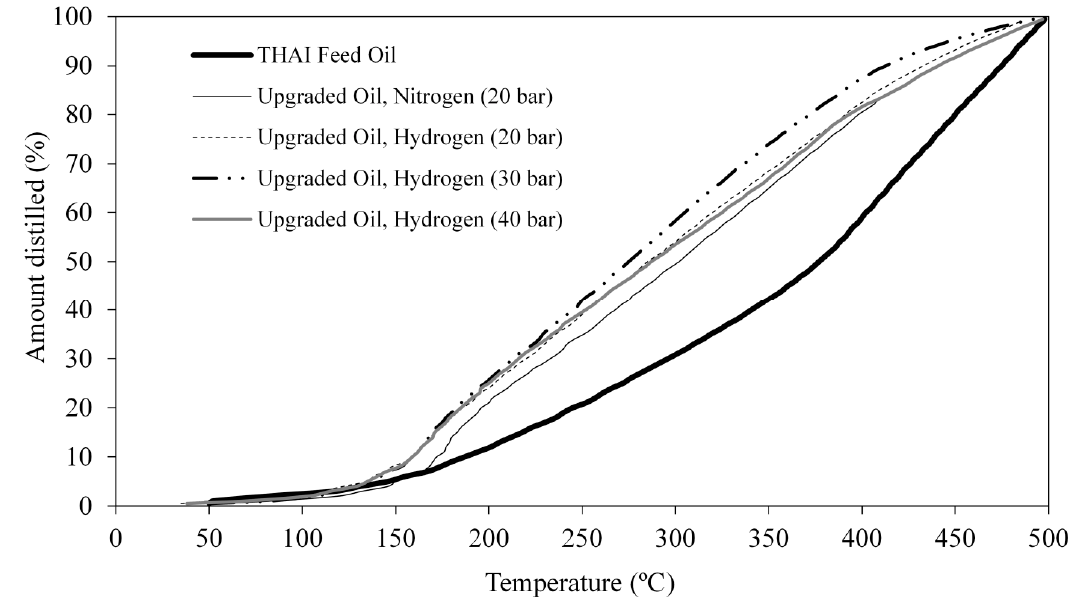
Figure 3. The TBP distribution of the THAI feed and upgraded oil.